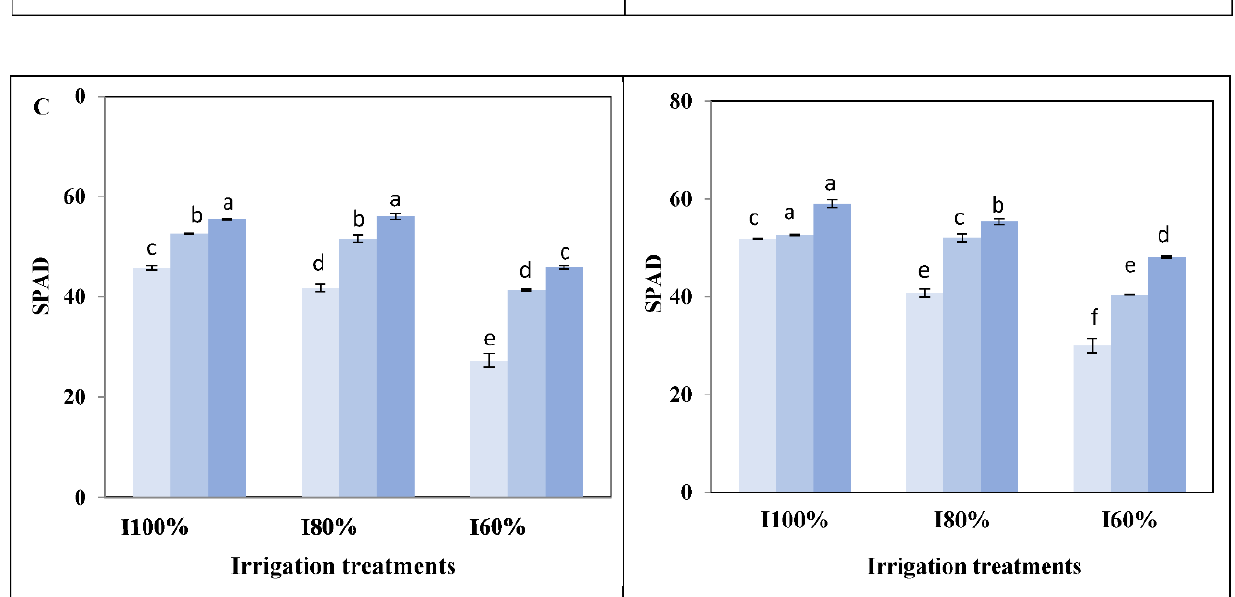
Figure 2. Effect of acidified biochar on ( A ) membrane stability index (MSI %), ( B ) relative water content (RWC %), and ( C ) chlorophyll content (SPAD) of faba bean plants grown under different irrigation treatments (I 100% , I 80% , and I 60% of ETc) in S I (2016/17) and S II (2017/18) seasons. Vertical bars represent means of 3 replications ± S.E ( p ≤ 0.05). Columns marked by different letters are significantly different.